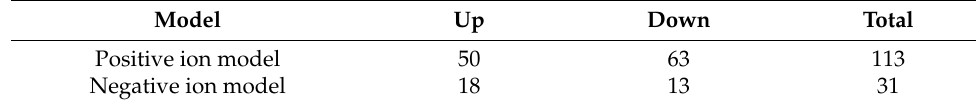
Table 2. Statistics of differential metabolites.